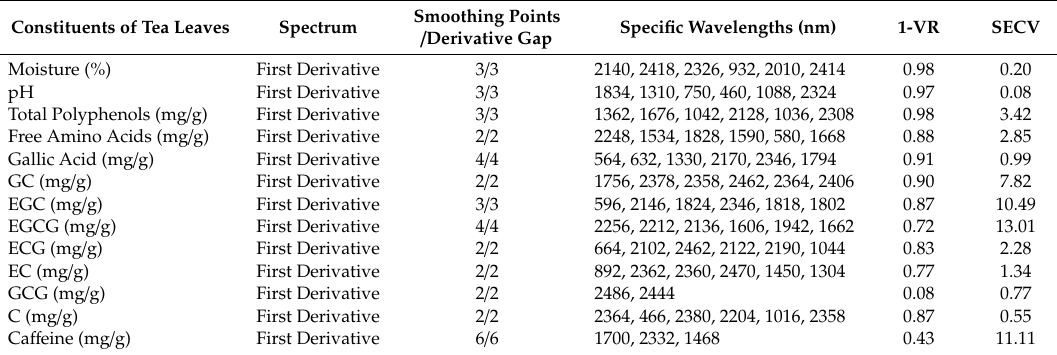
Table 4. Prediction of the constituents’ concentrations in teas using stepwise multiple linear regression models in the wavelength 400–2498